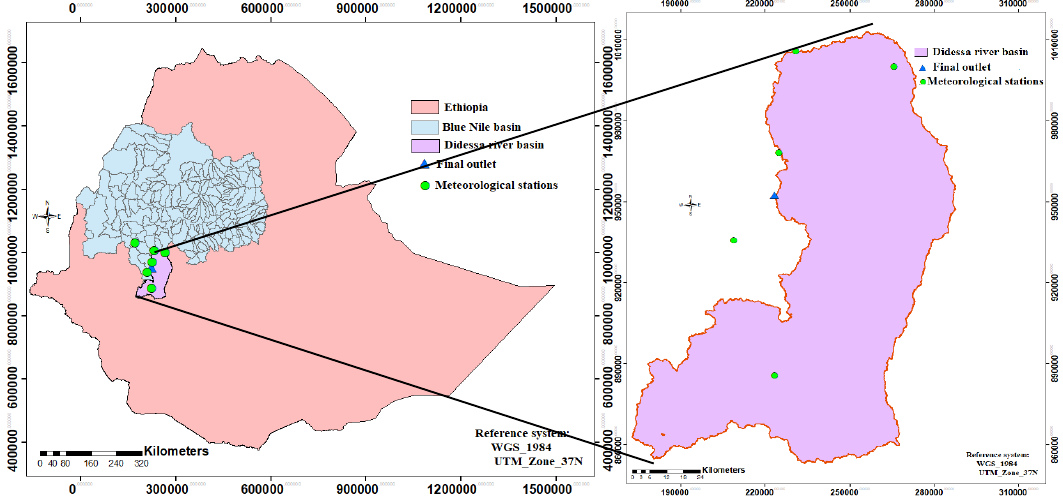
Figure 1. Location map of the Didessa riverbasin including the final outlet point.